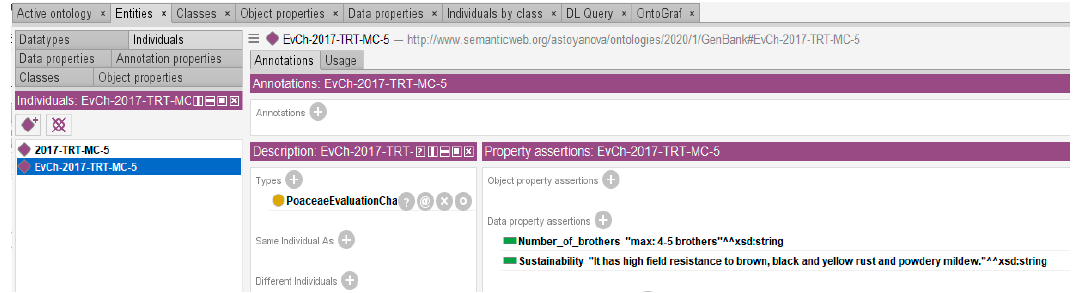
Figure 11. Evaluation characteristics of EvCh-2017-TRT-MC-5.